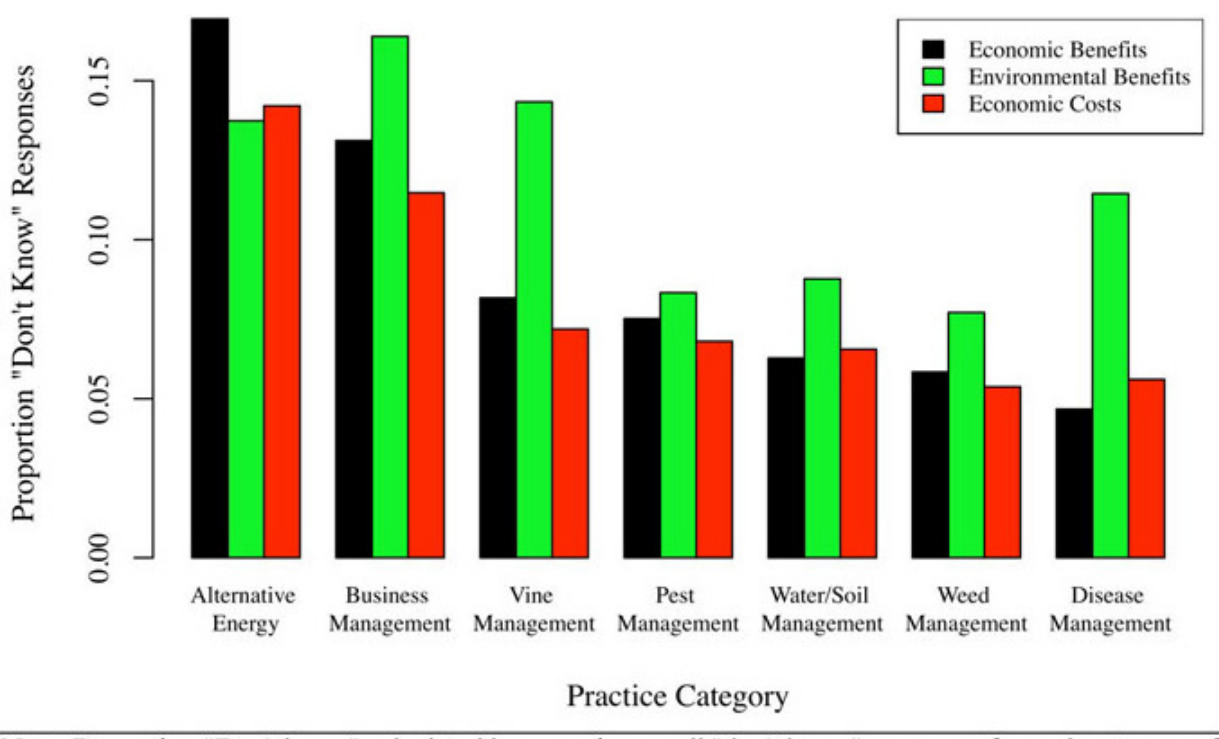
Fig. 4. Proportion of “don’t know” responses for each question and